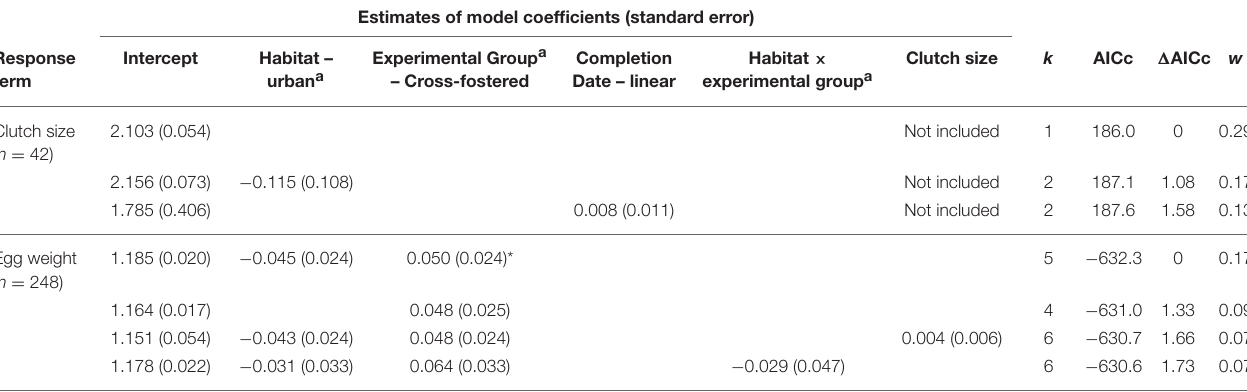
TABLE 4 | Summarizing table of statistical models employed to explain variation in natural clutch size and egg weight (in